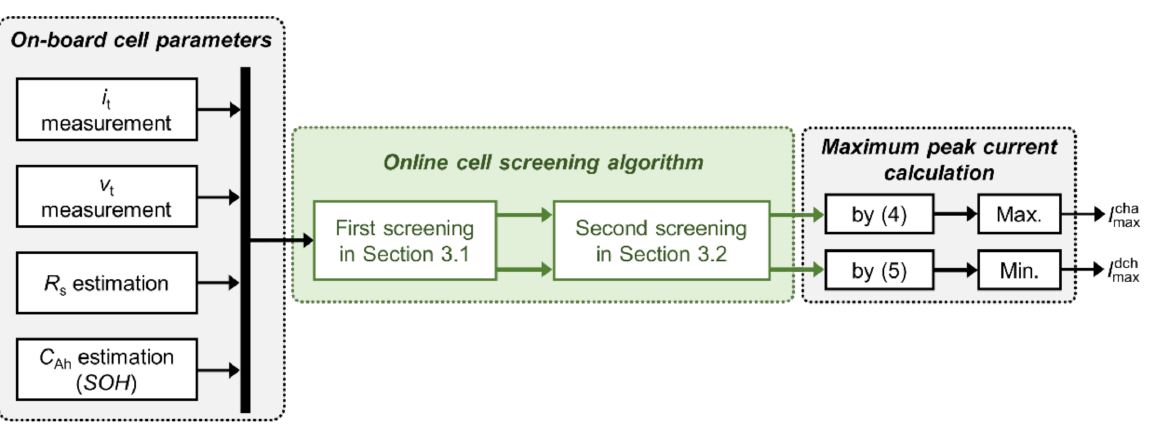
Figure 6. Scheme of the proposed online cell screening